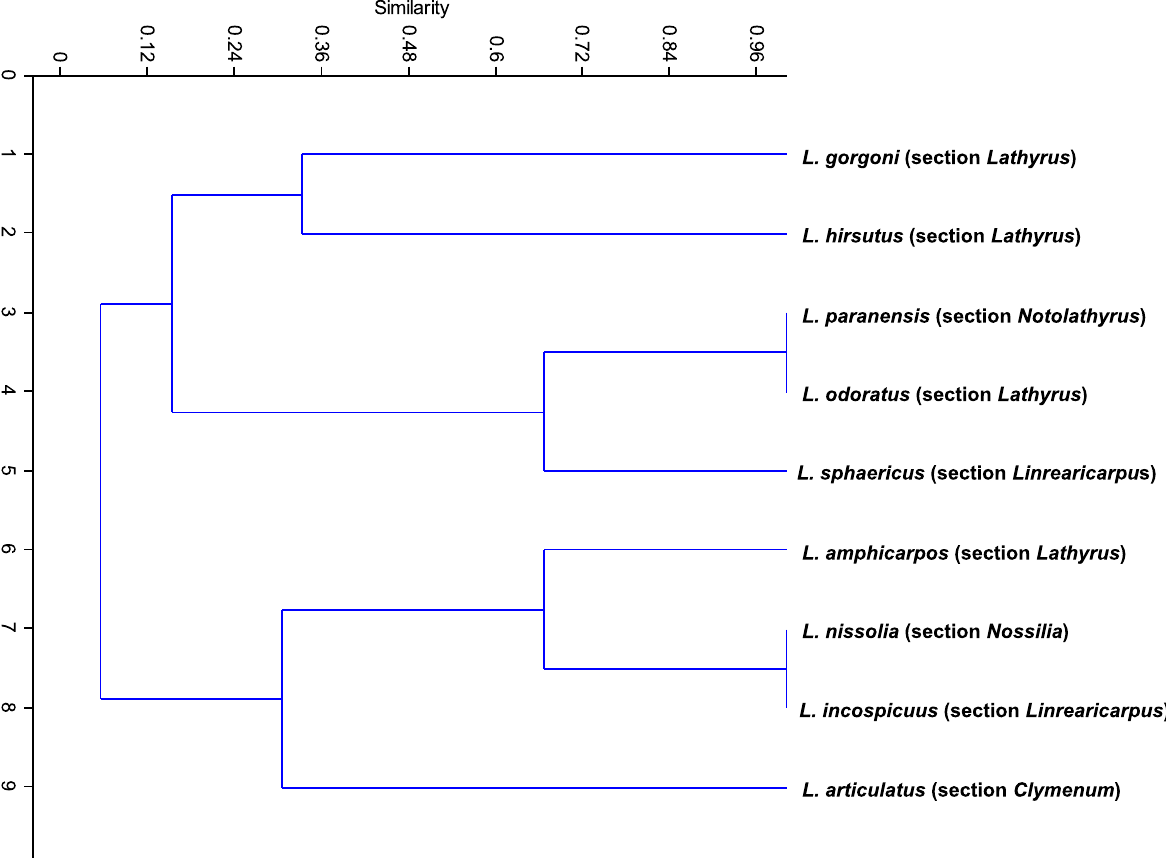
Fig. 3 Dendrogram of the studied Lathyrus species based on the number and loci of 5S and 45S